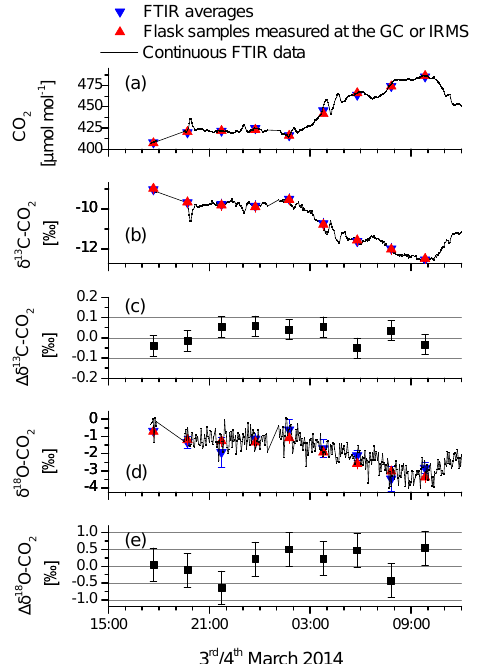
Figure 6. Diurnal cycle event sampled on the 3–4 March 2014 at the Institut für Umweltphysik in Heidelberg. Red: GC concentration (in case of CO 2 ) or IRMS isotopologue value (in case of isotopologues) of flasks samples; blue: 9min averaged values from FTIR; black: continuous 3 min values from the FTIR. (a) CO 2 mole fraction; (b) δ 13 C-CO 2 value; (c) residual of 9min average δ 13 C-CO 2 FTIR and IRMS measurement (FTIR - IRMS); (d) δ 18 O-CO 2 value; (e) residual of 9min averaged δ 18 O-CO 2 FTIR and IRMS measure- ment (FTIR – IRMS). All error bars on the (blue) averaged FTIR data are the standard deviation during the 9min of averaging time. The error bars on the (red) IRMS values show the typical inter- mediate measurement precision of our IRMS measurements. The residual (FTIR-IRMS) has an error bar, which combines the IRMS uncertainty and the FTIR uncertainty and the variability of atmo- spheric signal during the flask filling